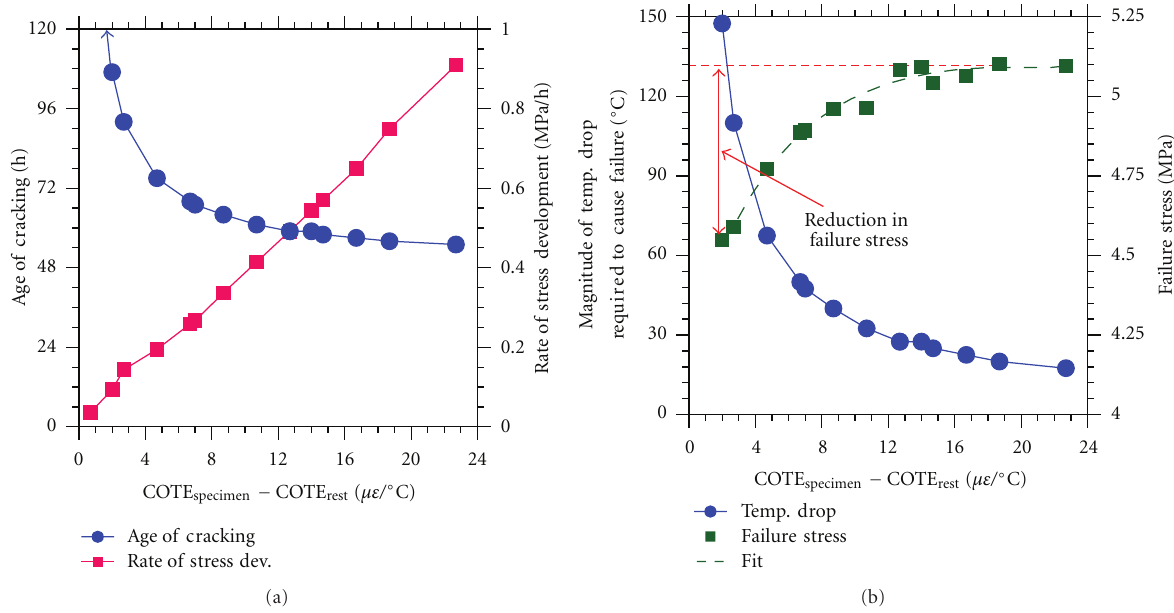
Figure 11: Influence of relative thermal deformations of the mortar and restraining rings on (a) the rate of stress development, age of cracking, (b) the magnitude of temperature drop, and the reduction in average stress of dual ring specimen at